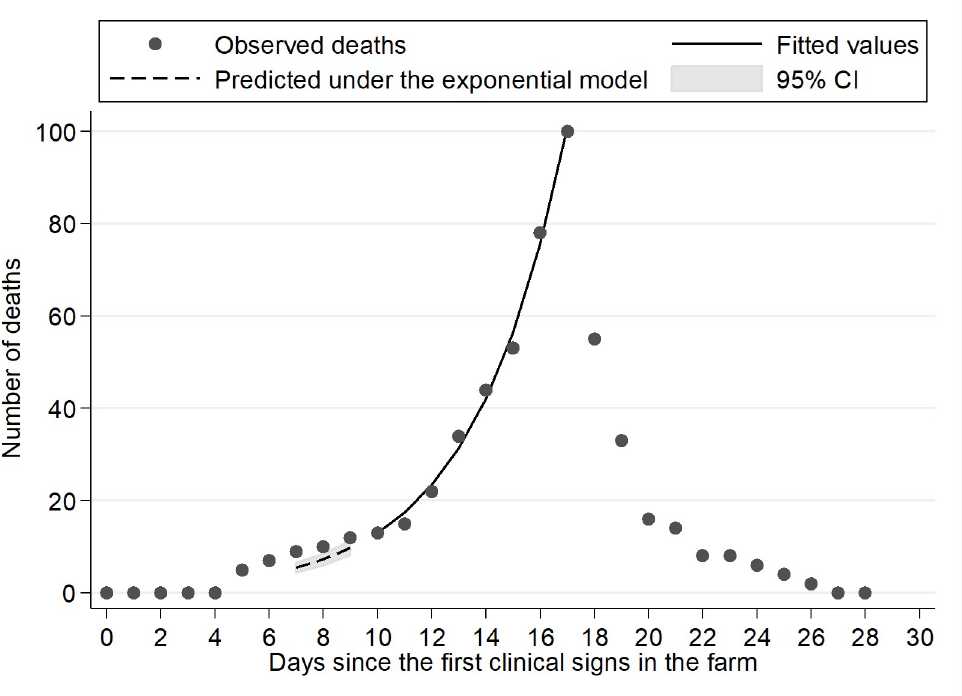
Fig 7. Observed number of deaths in farm A and fit of an exponential model for the days (D) 10–17. Τ he deaths observed in D5 and D6 are all attributed to initial infections from humans to minks. The difference between the observed number of deaths in D7-to-D9 and that estimated under the exponential model was used to estimate the number of deaths attributed to the initial infections from human-to-mink.